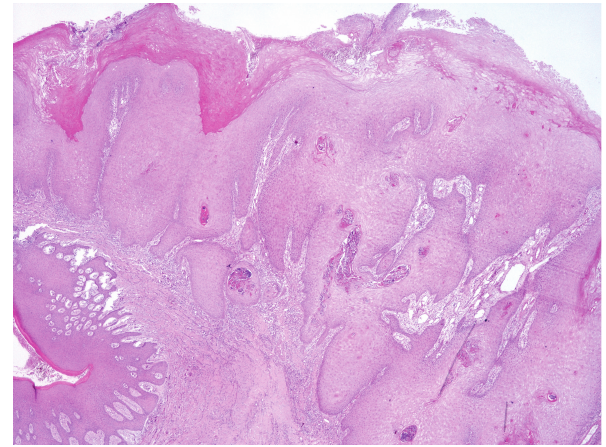
Figure 2: Microscopic aspects supporting diagnosis of verrucous carcinoma. Note the broad pushing blunt squamous epithelial downgrowths that are diagnostic of verrucous carcinoma (Haema- toxylin and Eosin, ×